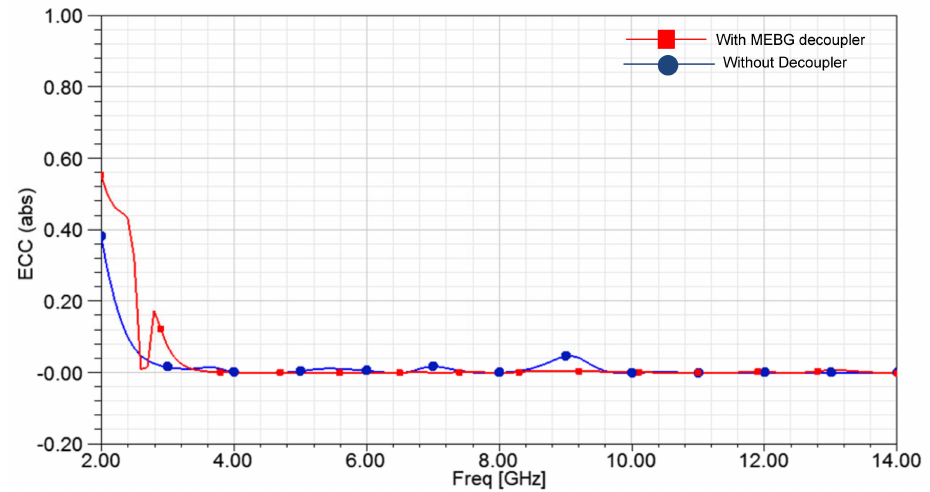
Figure 13. Envelop correlation coefficient with and without MEBG decoupling structure.